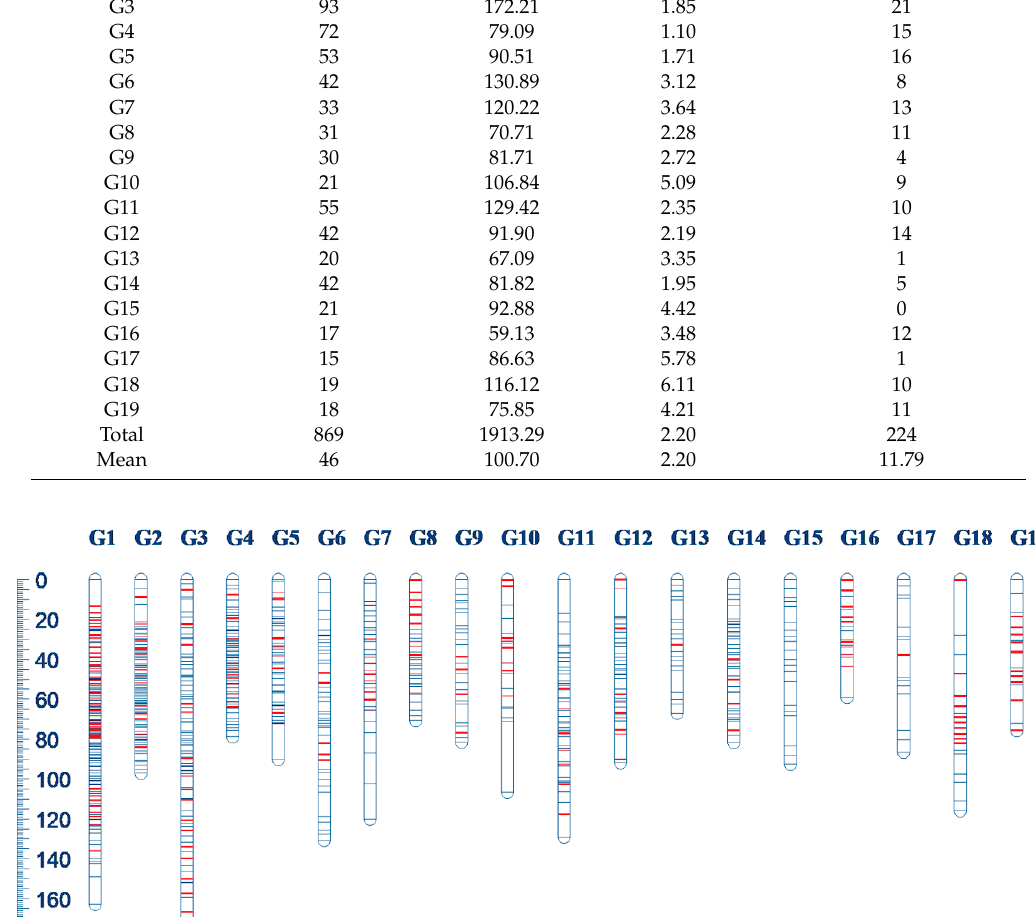
Table 1. Distributions of markers on 19 linkage groups of Eucommia ulmoides.